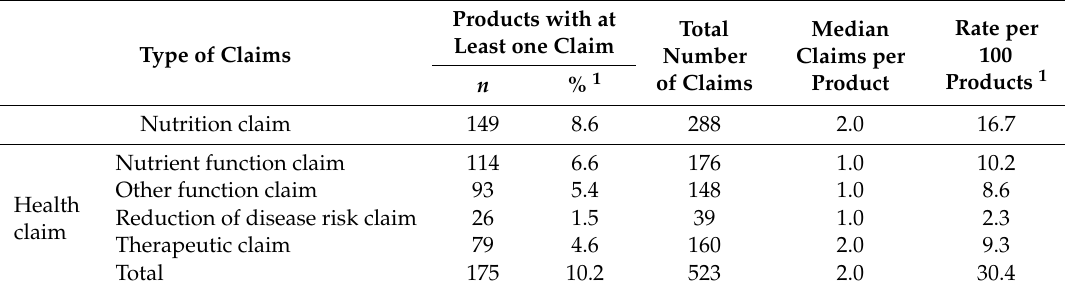
Table 3. Prevalence of nutrition and health